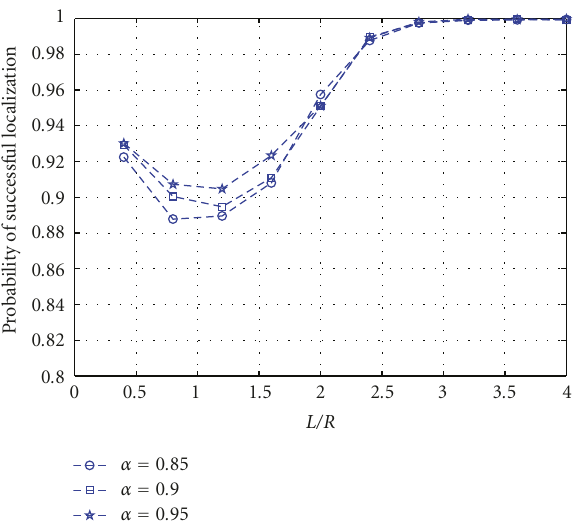
Figure 11: The e ff ect of α on enhanced TSCD scheme.